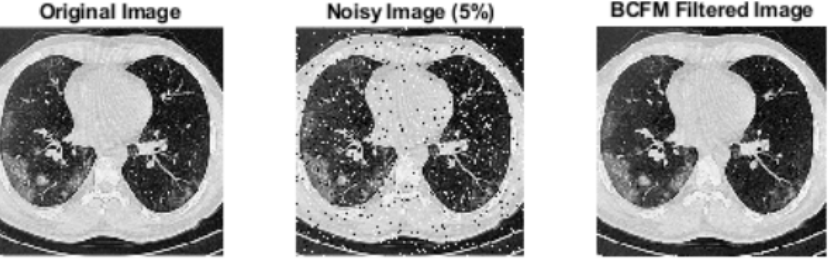
Figure 11. 1. Original COVID-19 image. 2. Noisy image after adding noise. 3. BCFM filtered image for n = 10 bootstrap resampling.